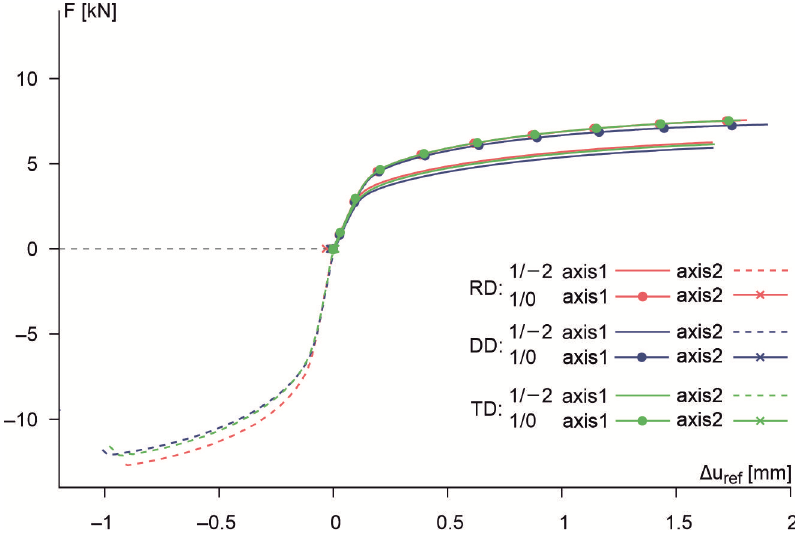
Figure 4. Load displacement curves of biaxial experiments. Numerical simulations with the anisotropic material model presented in Section 2 provide valuable information regarding the stress triaxiality in the notched region of the specimen. For F 1 / F 2 = 1/0 loading, the stress triaxiality was very homogeneously distributed in the cross-section of the notch with values of approximately 0.1 (Figure 5a). The influence of the material direction was small but visible; for instance, the experiment in rolling direction, Figure 5a (RD), indicates marginally higher values. The numerical simulations with loading ratio F 1 / F 2 = 1/ − 2 indicate negative stress triaxialities with values between − 0.48 and − 0.30. Due to the superimposed compression, the effect of the notched geometry led to unavoidable gradients in the distribution.